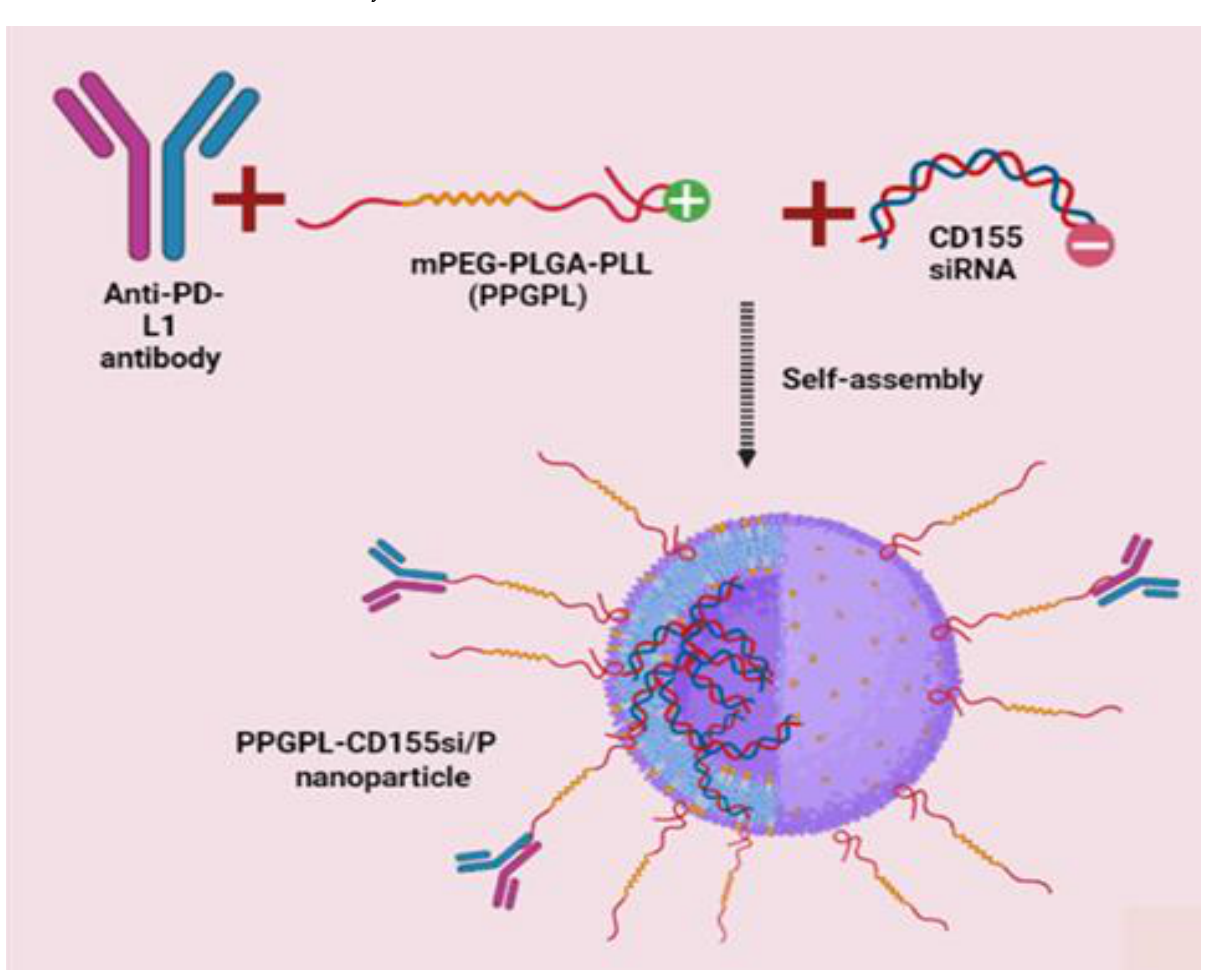
Figure 3. Schematic representation of designing mPEG-PLGA-PLL (PPGPL) polymeric nanoparticles loaded with CD155siRNAand covered with PD-L1 antibodies on the exterior surface to block CD155 and PD-L1 in a spatio-temporal manner.